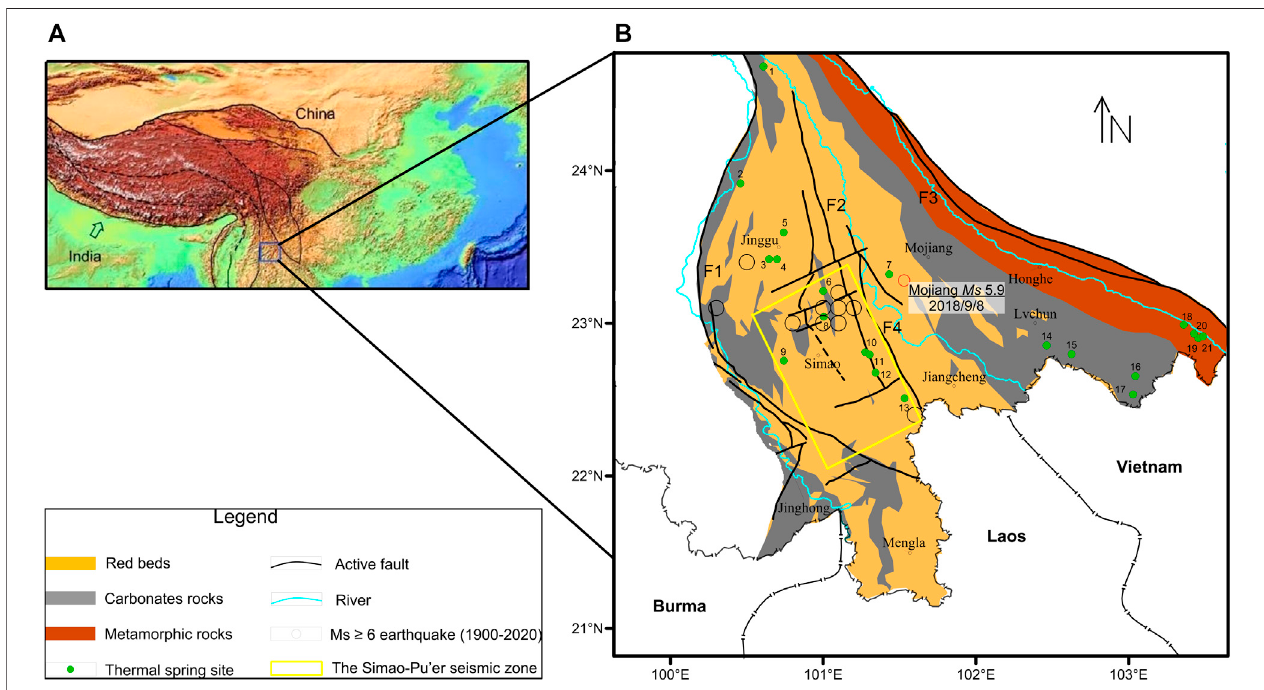
FIGURE 1 | Topographic map of the study area (A) and schematic tectonics and spring sites in the Simao Basin (B) ; modi fi ed from Zhang Y. et al., 2020). Abbreviations: F1, Lancangjiang fault; F2, Wuliangshan fault; F3, Ailaoshan fault; F4, Mohei fault.